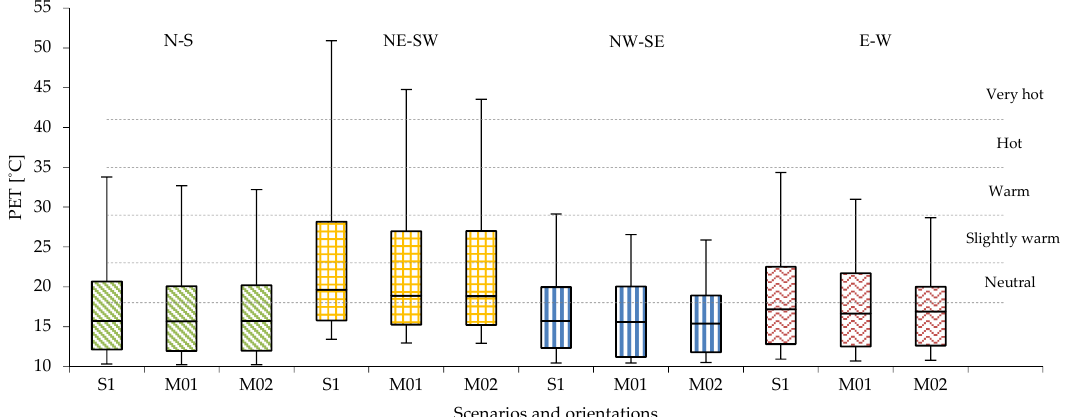
Table 15. Peak values of PET, for R01 (at the beginning of the urban canyon), R04 (in the middle) and R07 (at the end) in compact mid-rise urban areas for scenario S1, mitigation scenario M01 and M02. Scenario Orient.